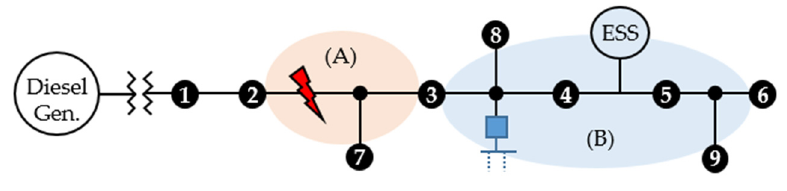
Figure 13. Service restoration plan using an ESS.